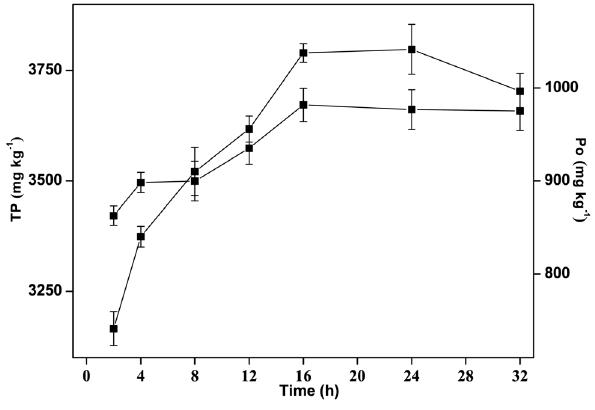
Figure 4. The total P (TP) and organic P (Po) concentrations found after different extraction